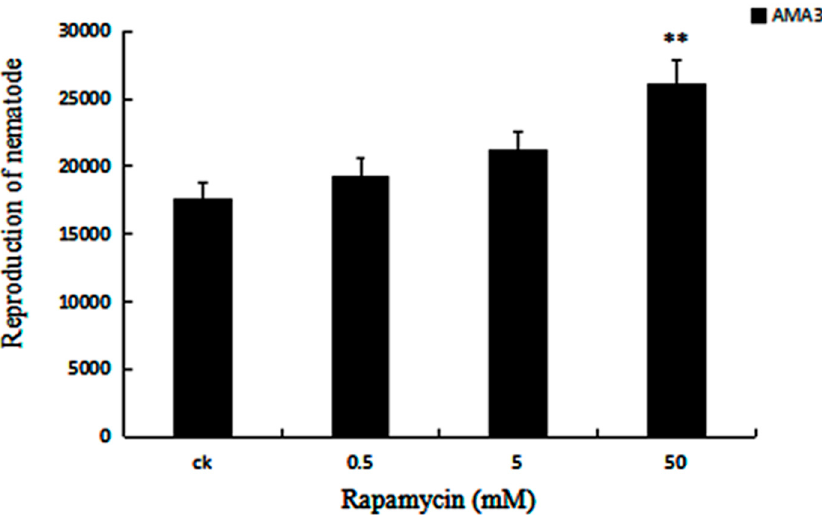
Figure 2. Effect of Rapamycin on reproduction of PWN. Reproduction rate of PWN washed from PDA plate of B. cinerea (ddH 2 O and 0.5, 5, and 50 mM Rapamycin). Data represent mean ± SD from three independent experiments. Bars show standard deviations of the mean. Asterisks on top of the bars indicating statistically significant differences between the Rapamycin-treated (0.5, 5 and 50 mM Rapamycin) nematodes and controls (** p < 0.01, Student’s t -test).